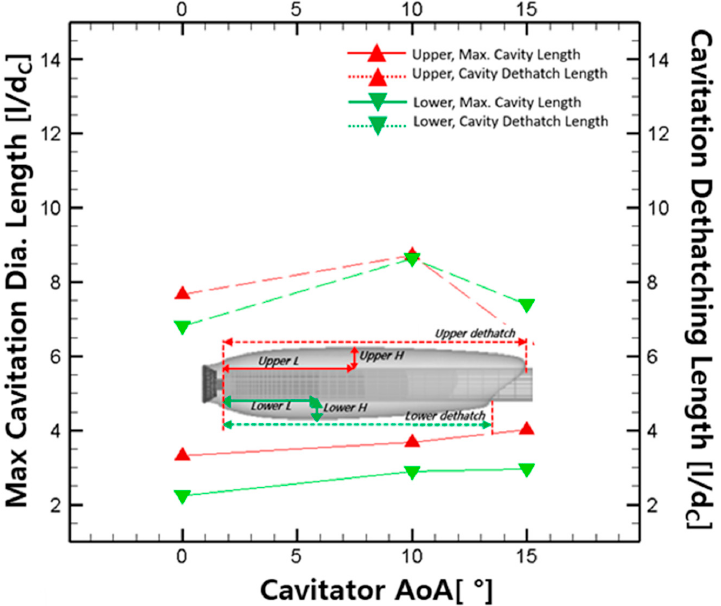
Figure 14. Comparison of length for maximum cavitation diameter and dethatch for various cavitator angles of attack.